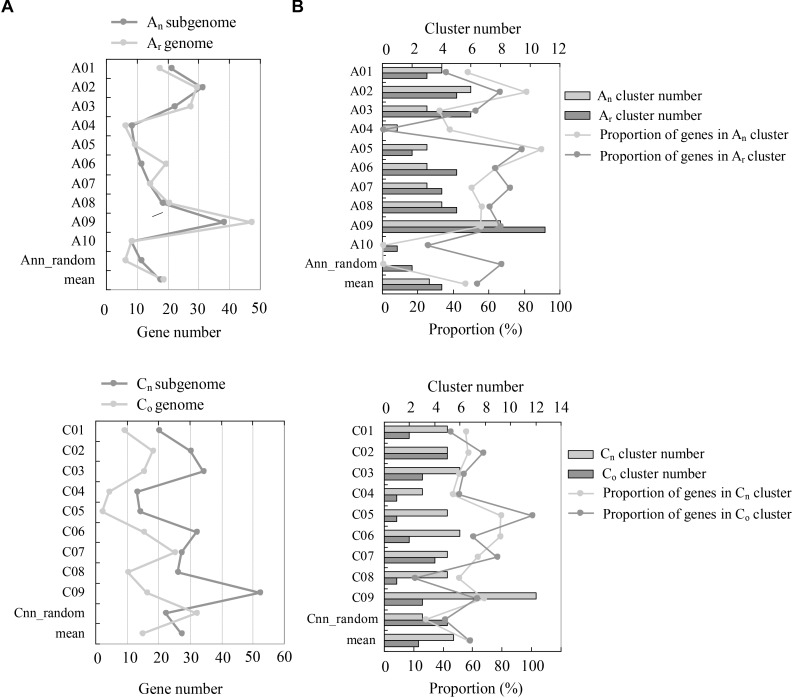
Comparison of NBS-encoding genes between the subgenomes of B. napus (AnAnCnCn) and the genomes of B. rapa (ArAr) and B. oleracea (CoCo). (A) The comparison of gene numbers between the genomes of Ar and An, and Co and Cn. The y-axis indicates the number of NBS-encoding genes located on each individual chromosome, and the x-axis represents the chromosomes. (B) The comparison of NBS-encoding gene clusters between the Ar and An, and Co and Cn genomes. The y-axis represents the chromosomes, while the x-axis represents the number of gene clusters and the proportion of genes located in each gene cluster, respectively.